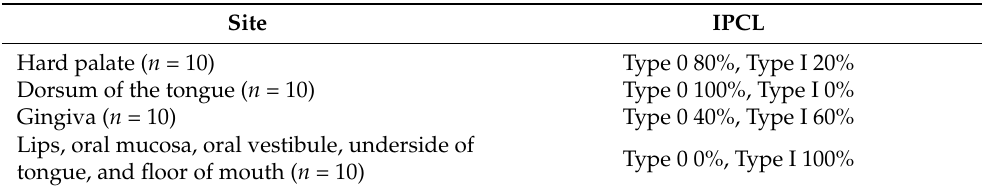
Table 2. Normal intraoral mucosa intraepithelial papillary capillary loop (IPCL) classification. The hard palate and the dorsum of the tongue had thick keratinized mucosa, which made IPCL observa- tion almost impossible. There were statistically significant differences between the groups (Fisher’s exact test, p <